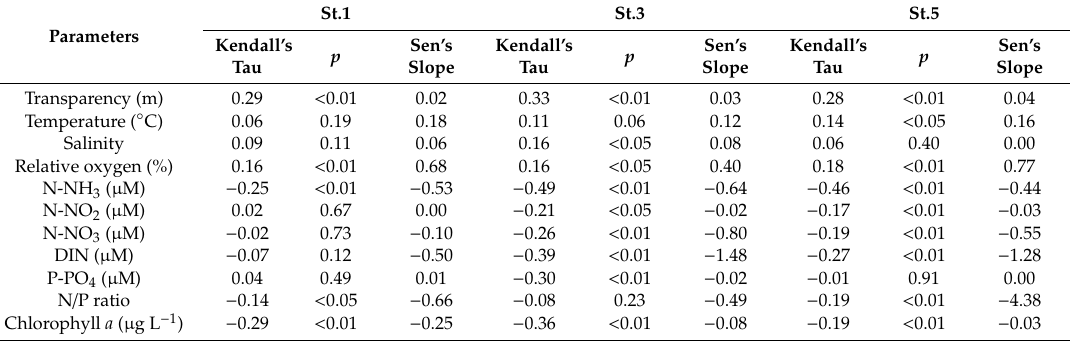
Table 3. Seasonal Kendall tests of the hydrochemical parameters: Kendall’s tau, significance of trend (p), and Sen´s slope estimator in units y − 1 . Period: 1998–2017 (except for transparency in St.5, measured from 2000